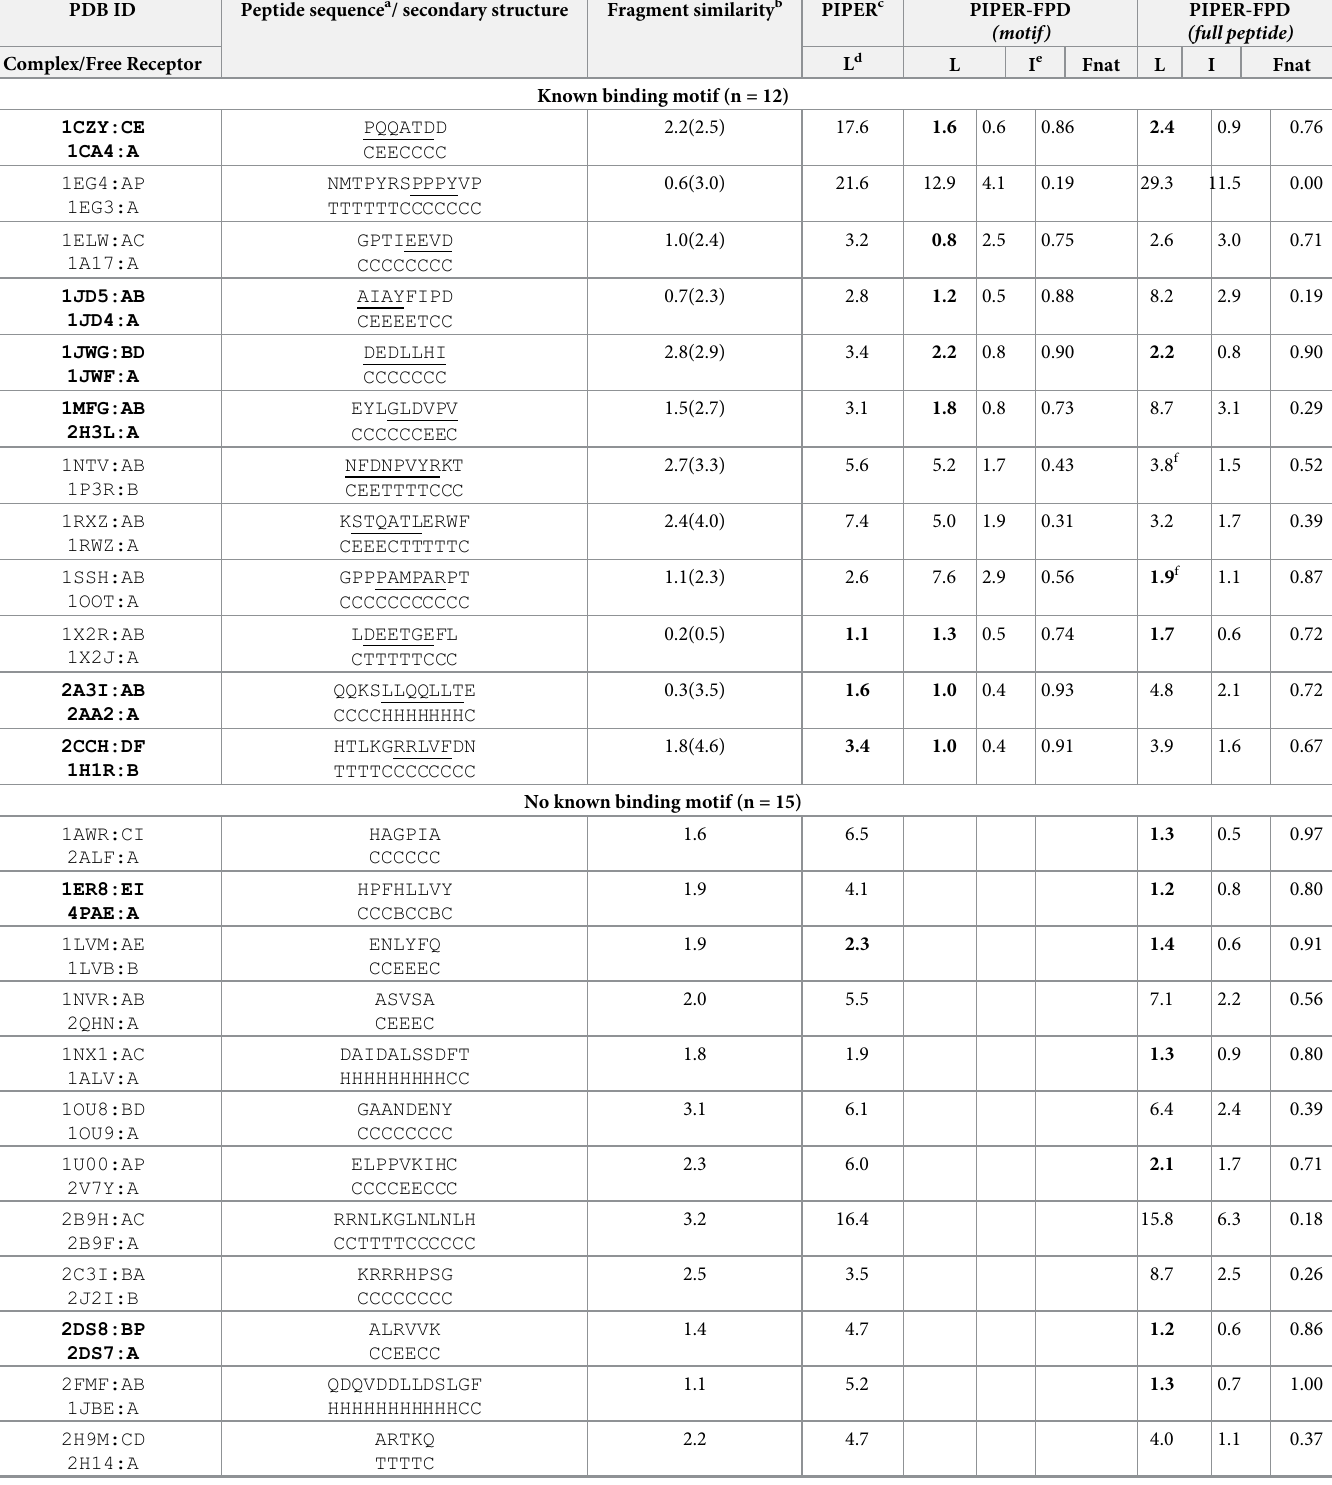
Table 1. Benchmark of peptide-protein complexes used in this study (non-redundant set; see S1C Table for full set). PDB ids of the initial calibration set are highlighted in bold. PDB